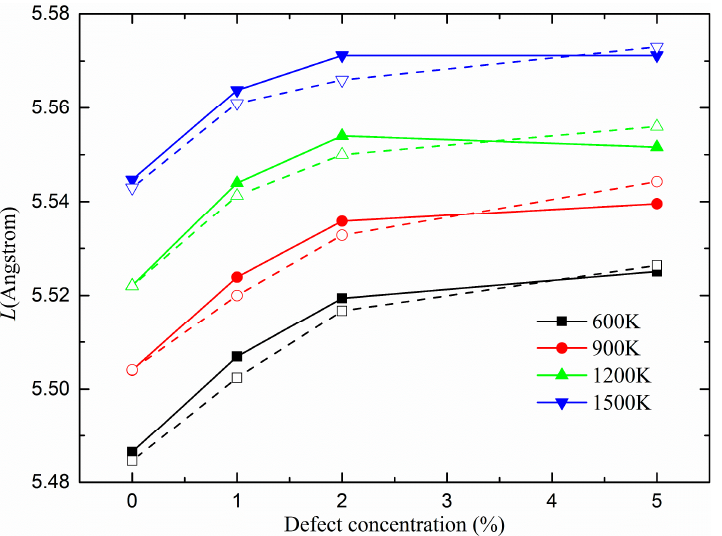
Figure 2. Dependence of lattice constant of UO 2 on defect concentration at different temperatures for Frenkel defects (dash) and antisite defects (solid).